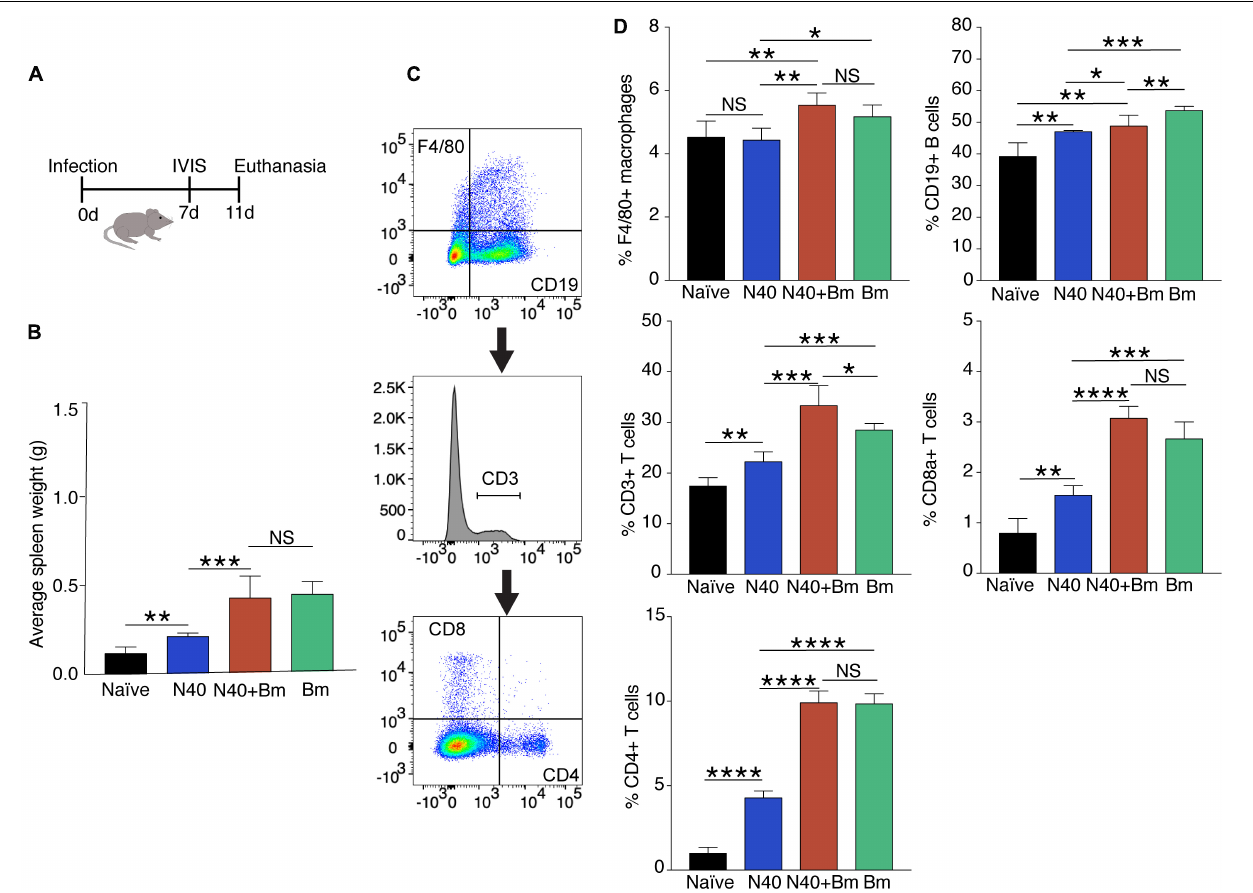
FIGURE 3 | Babesia microti (Bm) infection caused splenic enlargement in C3H mice at the acute phase of infection and differentially increase splenocytes compared to N40-infected mice. (A) Overall experimental plan and samples analyses after infection of C3H/HeJ female mice. (B) Splenic weights were determined on day 11 p.i. Spleens of Bm infected and co-infected mice were significantly heavier than spleens from N40 infected mice, which showed moderate increase in weight compared to naïve mice. (C) Gating scheme used for FACS analysis of splenic CD45+ cells is shown. (D) Quantitative analyses of splenic B cells, T cells, CD4+ and CD8a+ cells, and macrophages in each group of mice. Each cell type is represented as percentage of total CD45+ splenic leukocytes (mean ± s.d., n = 5). Two-tailed unpaired student t- test for unequal variance between the paired groups was used to determine significance (NS, not significant, ∗ p < 0.05, ∗∗ p < 0.01, ∗∗∗ p < 0.001, ∗∗∗∗ p <